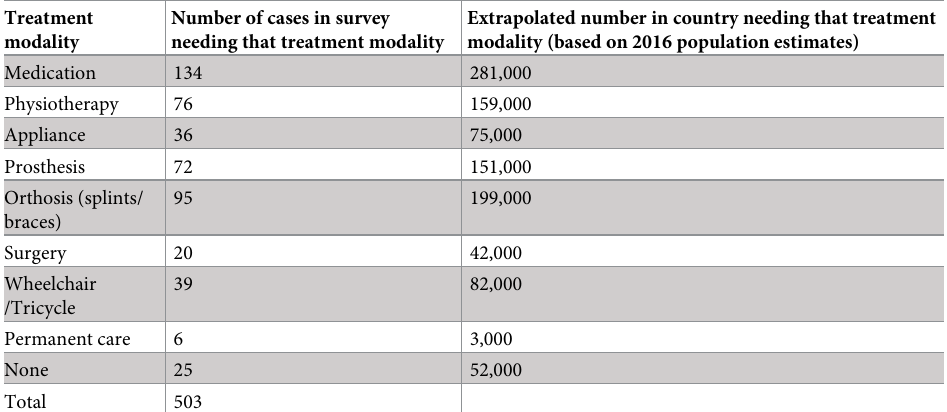
Table 8. Treatment needed among cases with MSI in survey and extrapolated to population of Malawi. Treatment